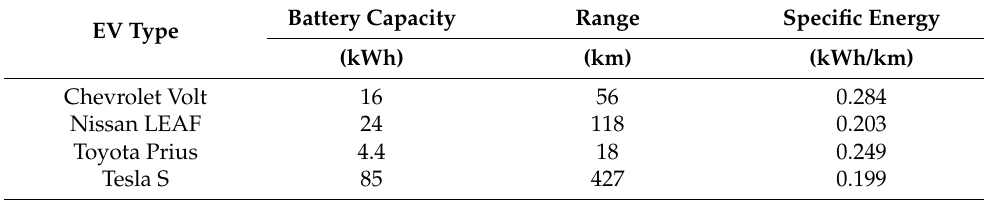
Table 1. Data for the EVs used in this research.